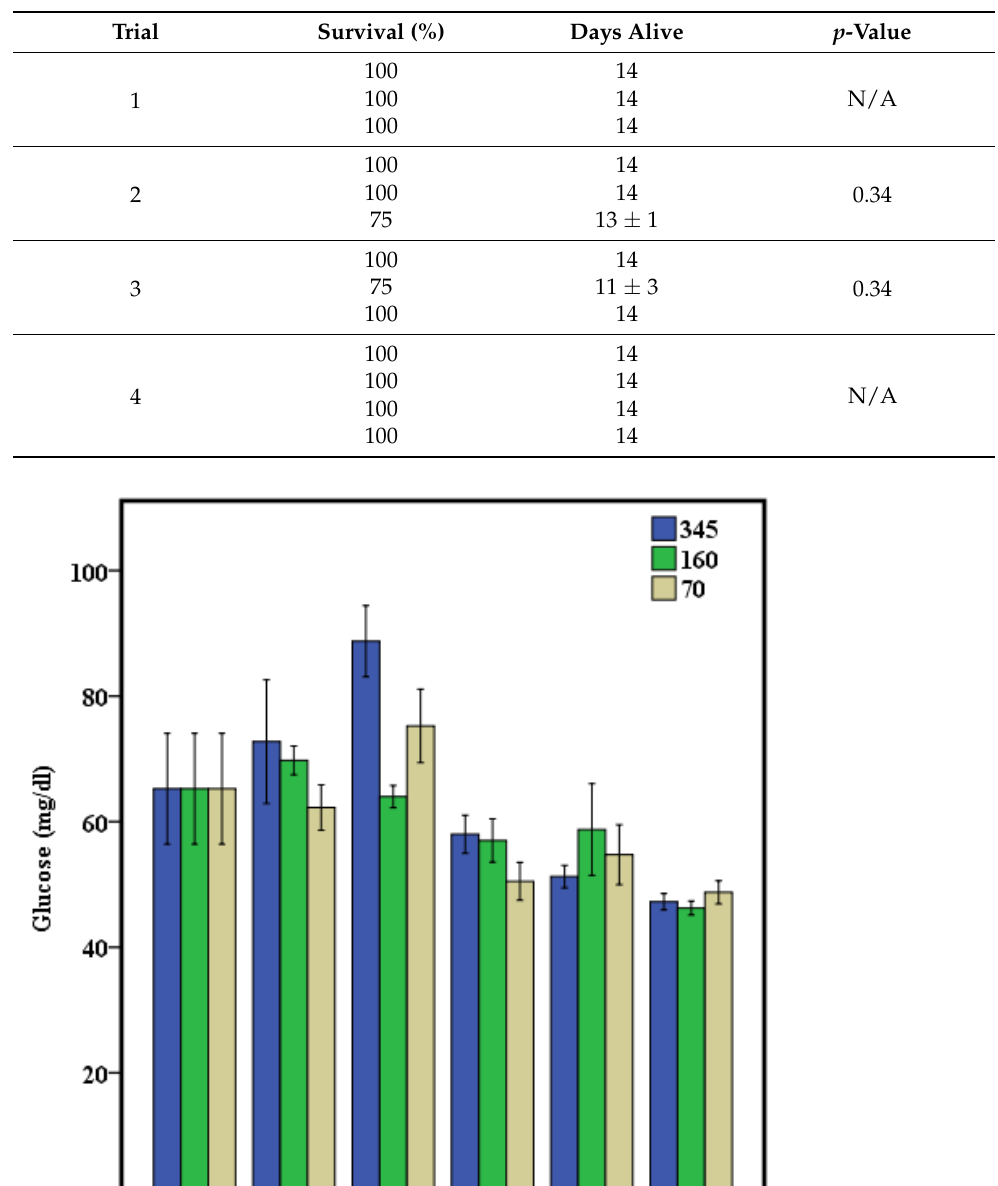
Table 2. Percent survival, number of days alive, and chi-square p -value for each of four trials testing 14-day survival of rainbow trout Oncorhynchus mykiss ( n = 4) exposed to different water hardness levels.